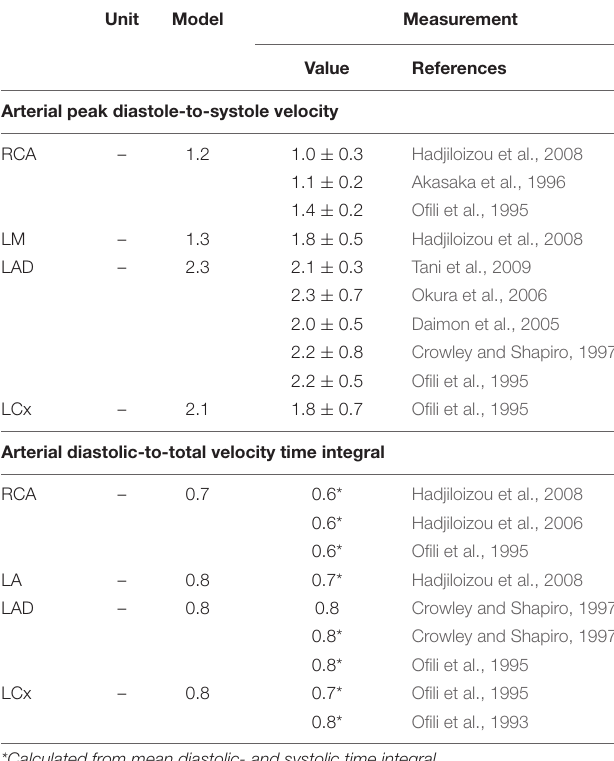
TABLE 3 | Quantitative comparison of model arterial flow with in vivo measurements.